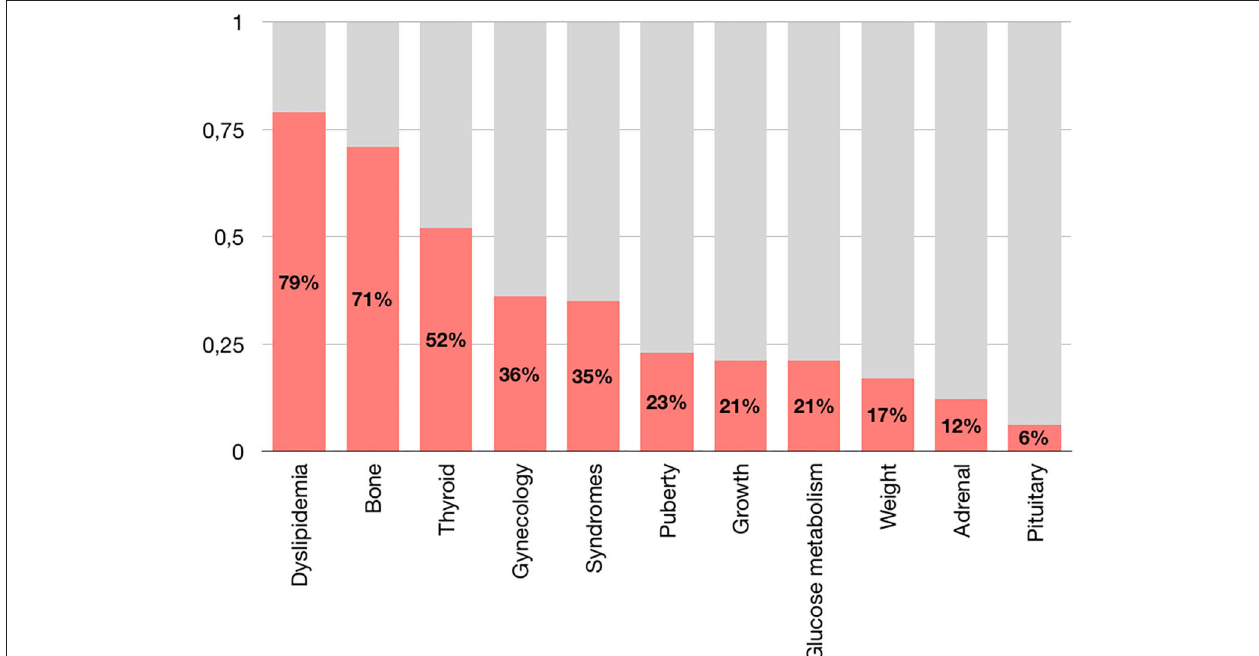
FIGURE 5 | Prevalence of pathological findings in cumulative groups of